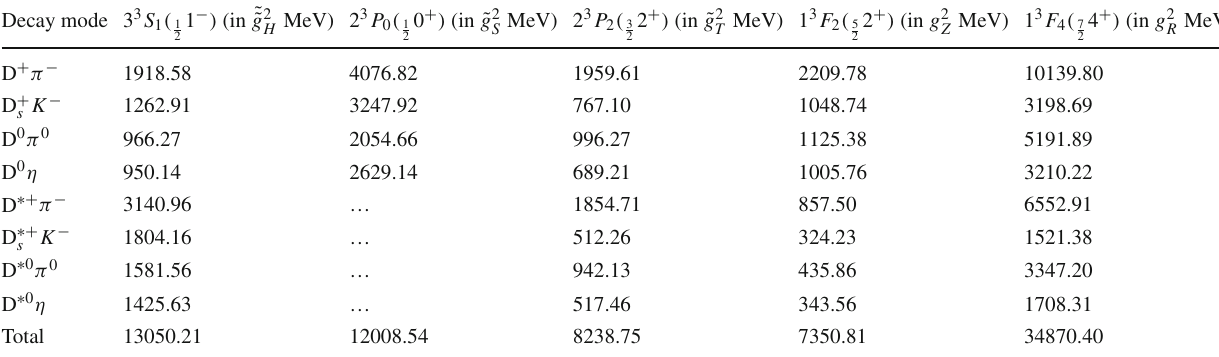
( 3000 ) with possible spin-parity assignments J